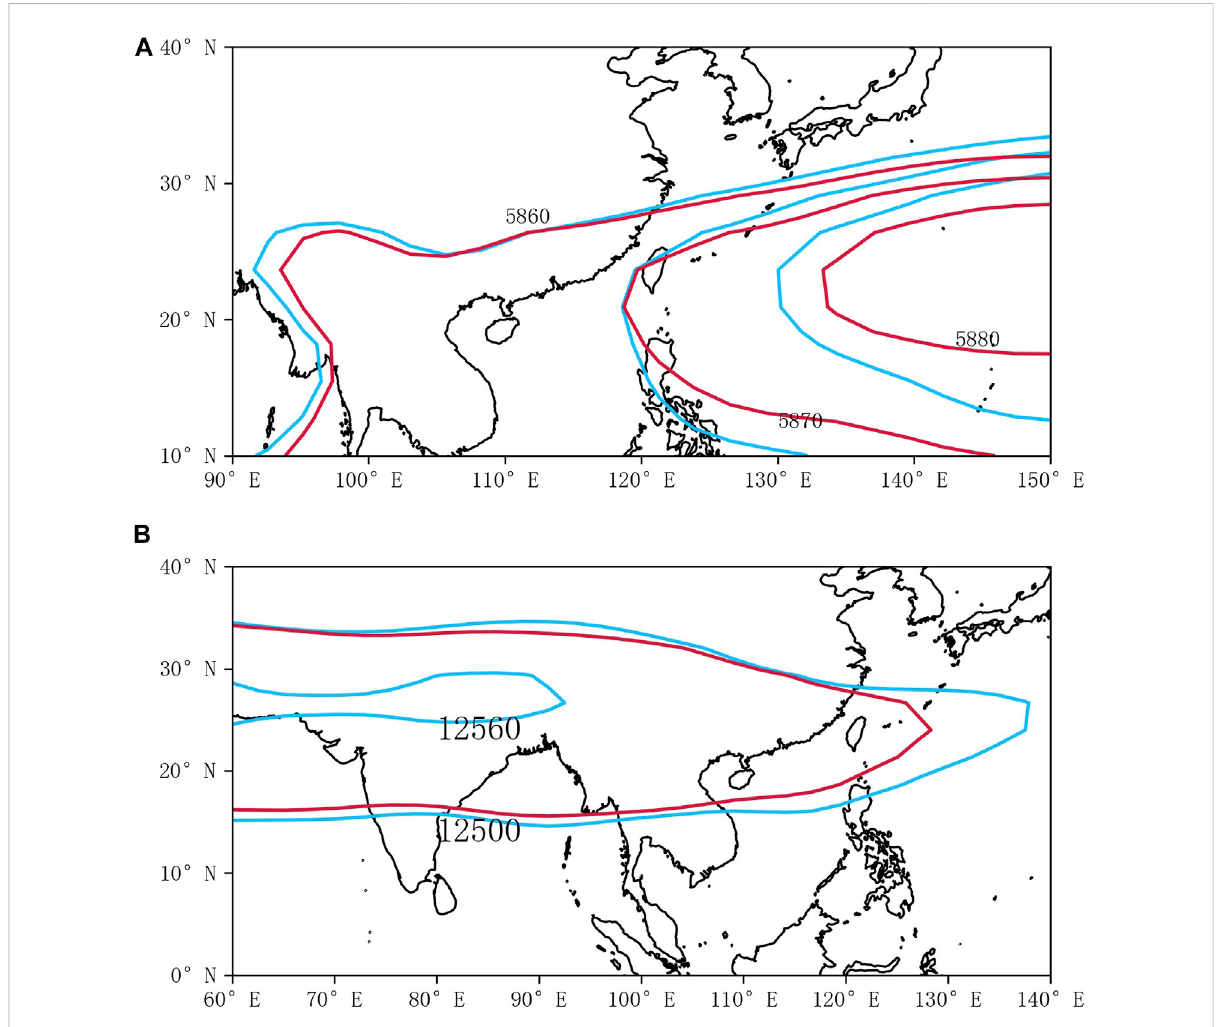
FIGURE 6 P1 period (red line) and P2 period (blue line): 500 hPa (A) geopotential height; 200 hPa (B) geopotential